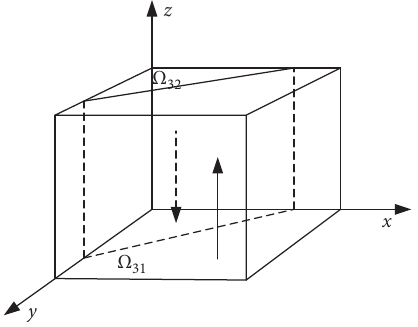
Figure 4: Dynamic evolution of banks’ decisions